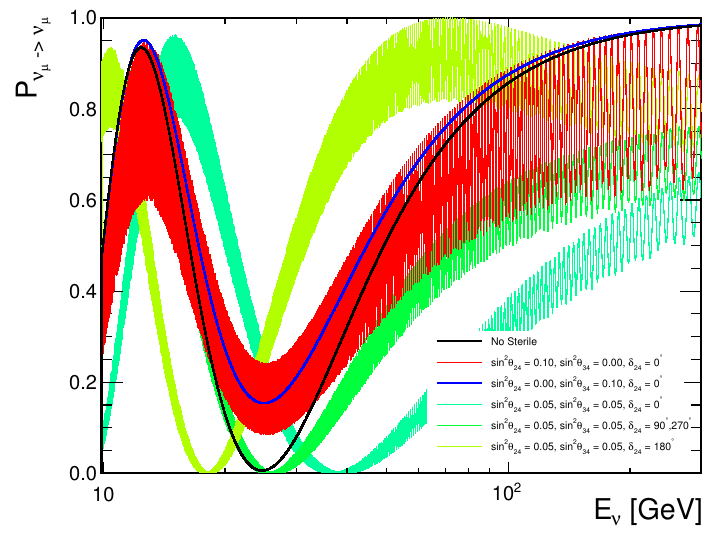
Figure 1 . Survival probability of vertically up-going (cid:23) (cid:22) as a function of neutrino energy (calculated with [8]) for di(cid:11)erent values of mixing angles (cid:18) 24 , (cid:18) 34 and (cid:14) 24 with (cid:1) m 2 2 : 5 (cid:1) 10 (cid:0) 3 eV 2 and sin 2 2 (cid:18) 23 =